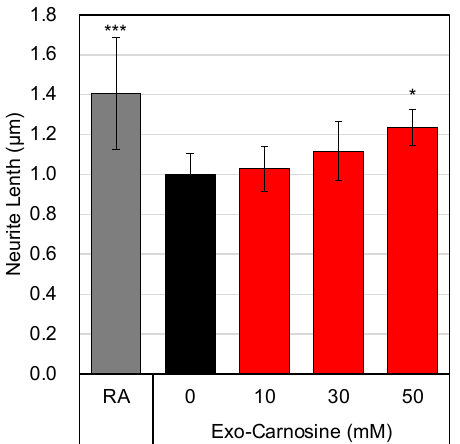
Figure 6. Exosome derived from carnosine-treated C2C12 cells activated neurite outgrowth in SH-SY5Y cells. Exosomes were prepared from carnosine-treated C2C12 cells by MagCapture Exosome Isolation kit and added to SH-SY5Y cells. As a positive control, SH-SY5Y cells were cultured with 10 µM of RA for 1 day. Neurite outgrowth in SH-SY5Y cells was evaluated by using IN Cell Analyzer 2200. Multiple comparisons between groups were performed using one-way ANOVA with Tukey’s post-hoc test. Statistical significance was defined as p < 0.05 when compared to control (* p < 0.05; *** p < 0.001).